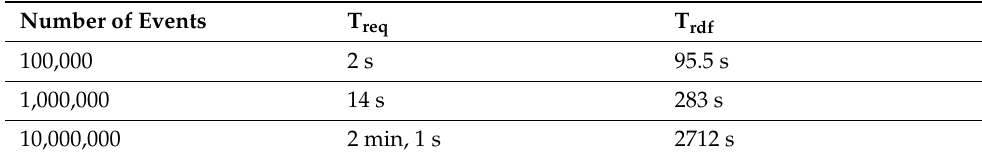
Table 4. System modeling results NoN =